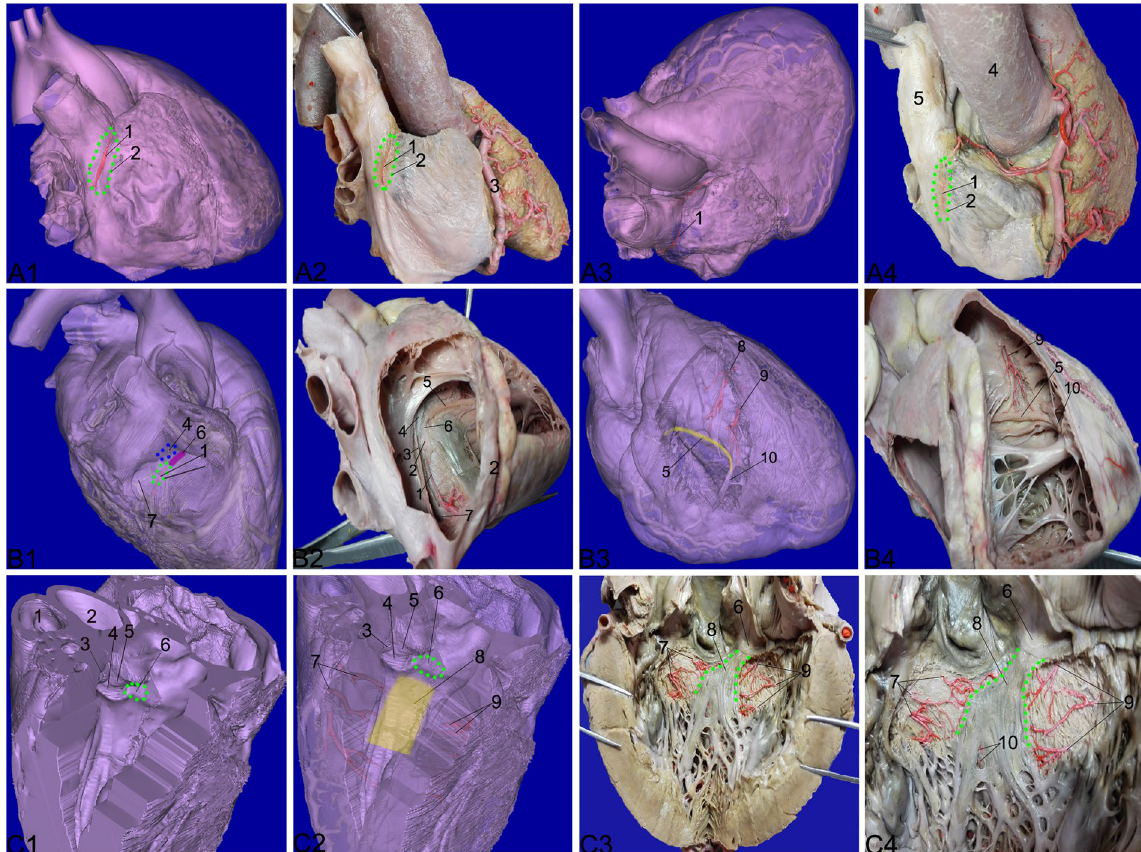
Figure 6. The 3D model and gross specimen. A1 3D model of the 1 st sample. The SANA (in red) arises from the RCA and crosses the sulcus terminalis, penetrating the SAN (green circle). The SAN is located at the junction of the superior vena cava with the right atrium. A2 Corresponds to A1 and is the gross specimen of the 1 st sample. A3 and A4 Viewed from the base to display the course of the SANA (1 SANA; 2 SAN; 3 RCA; 4 aorta; 5 superior vena cava). B1 3D model of the 2 nd sample. The AVNA (in red) arises from the posterior interventricular branch of the right coronary artery, penetrating the atrioventricular junction. The AVN (green circle) is at the apex of the triangle of Koch. The HBB (purple region) is situated below the atrioventricular part of the membranous part (blue circle). B2 Corresponds to B1 and is the gross specimen of the 2 nd sample. B3 3D model of the 2 nd sample. The RBB (yellow region) goes towards the right side of the interventricular septum at the crest, penetrating the moderator band. Its nutritious artery is the septal artery (in red). B4 Gross specimen of the 2 nd sample and corresponds to B3 (1 AVNA; 2 AVN; 3 the tendon of Todaro; 4 atrioventricular part of the membranous septum; 5 RBB; 6 HBB; 7 opening of the coronary sinus; 8 first septal artery; 9 second septal artery; 10 moderator band). C1 and C2 3D model of the 3 rd sample. The LBB (yellow region) is situated at the lower rim of the membranous septum (green circle) and is supplied by both the anterior and posterior septal arteries (in red). C3 and C4 Gross specimen of the 3 rd sample was dissected with reference to the 3D model of the 3 rd sample (1 pulmonary trunk; 2 aorta; 3 right semilunar cusp; 4 left semilunar cusp; 5 posterior semilunar cusp; 6 membranous septum; 7 anterior septal arteries; 8 LBB; 9 posterior septal arteries; 10 nutritious arteries of